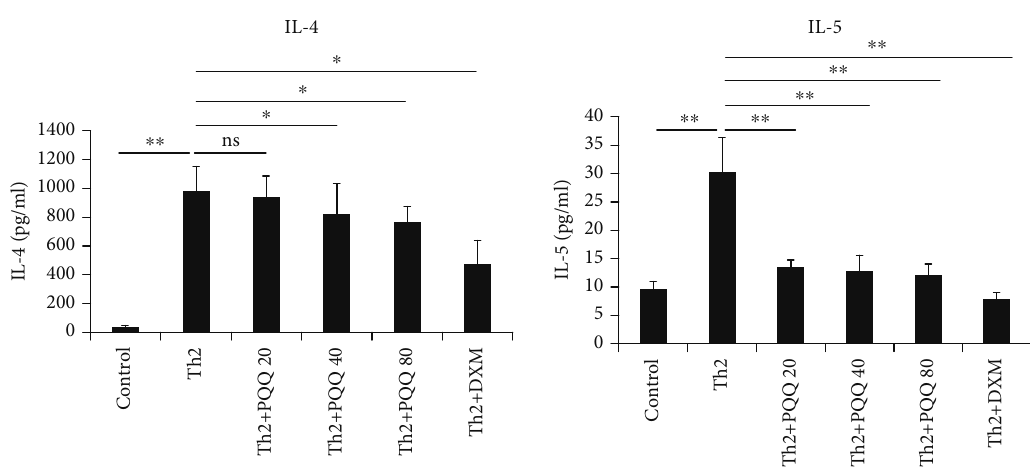
Figure 2: PQQ administration inhibits Th2 cell di ff erentiation. CD4+ T cells were primed under Th2 conditions. PQQ and DXM were added. Five days later, the cells were stimulated with PMA and ionomycin. The Th2 cytokines were measured using an ELISA kit. The columns and error bars represent the means and SEMs ( n = 3 per group). ∗ P < 0 : 05 , ∗∗ P < 0 : 01 ; ns: not statistically signi fi cant. Similar results were obtained in three independent